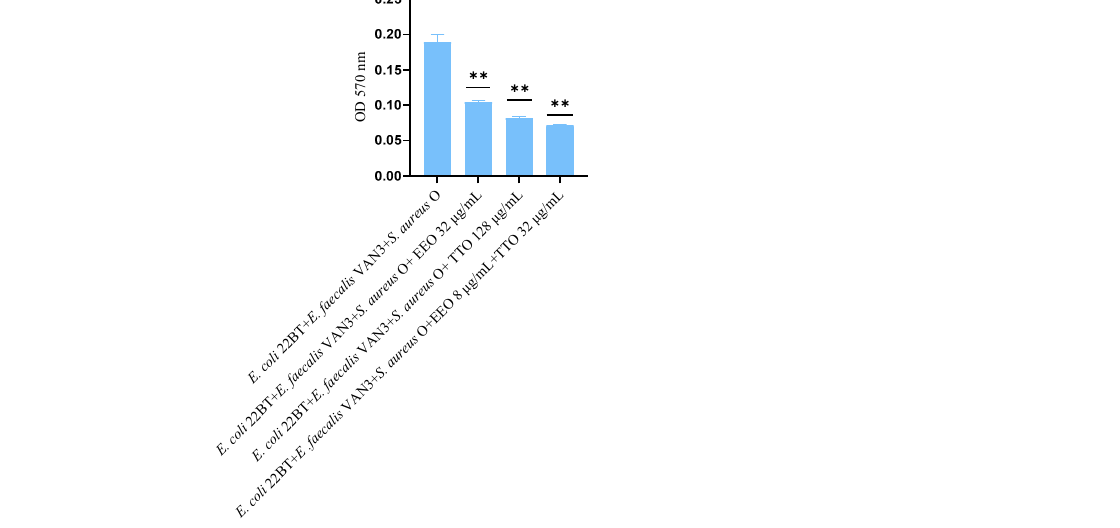
Figure 6. Anti- multi-species mature biofilm activity of Melaleuca alternifolia (TTO), Eucalyptus globulus (EEO) EOs and the association EEO/TTO. Results were expressed in optical density (OD) 570 nm as the arithmetic mean of the three determinations. p -values of <0.05 (*), p < 0.01 (**), p < 0.001 (***) and p < 0.0001 (****) were considered significant by t-test and ANOVA. The effectiveness of TTO ( p = 0.004) was better than EEO ( p = 0.006) in removing multi-species biofilms. The TTO/EEO association ( p = 0.003) once again demonstrated a